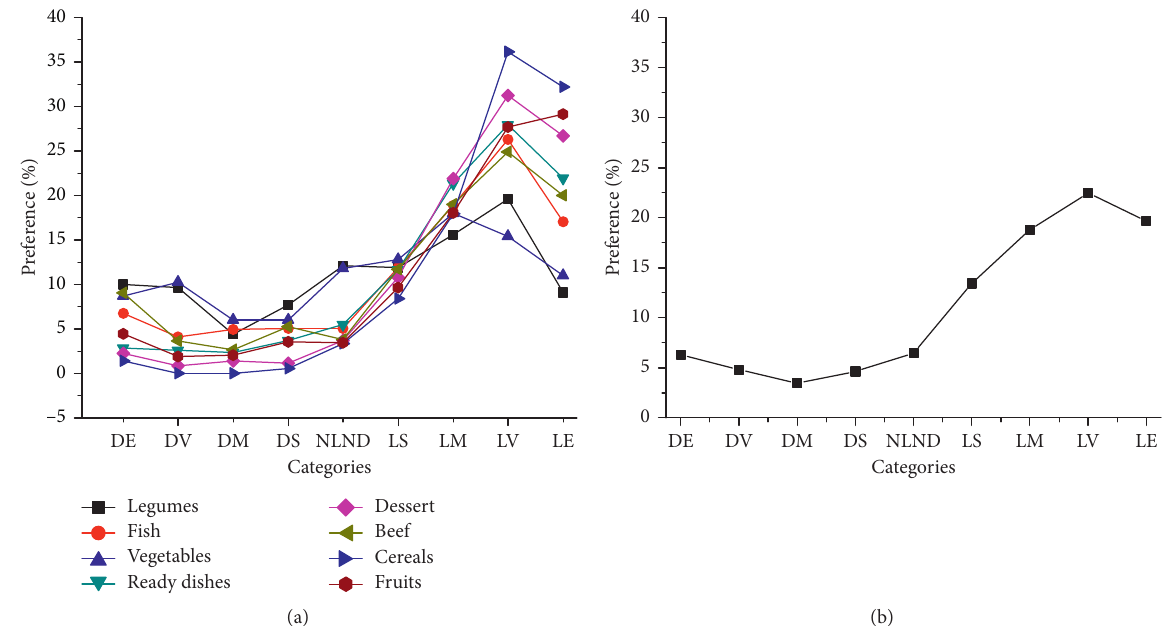
Figure 14: Food preference results. (a) All food groups. (b) All